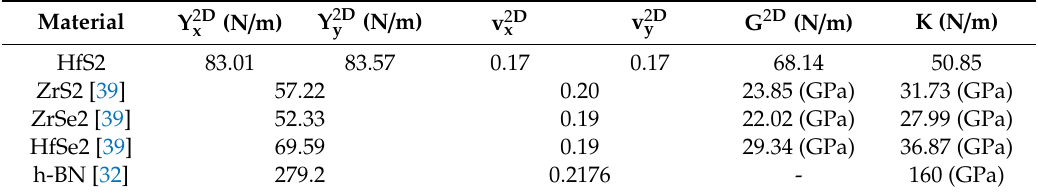
Table 5. 2D Young’s moduli, Poisson’s ratio, 2D shear modulus, and 2D bulk modulus for some 2D